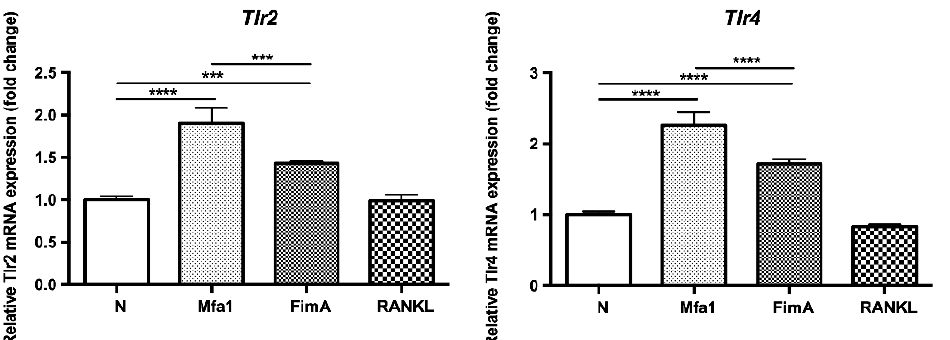
Int. J. Mol. Sci. 2022 , 23 , 15293 Figure 3. Effects of fimbriae on the expression of osteoclast differentiation marker genes in RANKL- prestimulated RAW264 cells. RAW264 cells were prestimulated with 50 ng/mL RANKL for 24 h and then cultured for 48 h in the presence of 1 µ g/mL Mfa1 and FimA fimbriae or 50 ng/mL RANKL. mRNA levels were then examined by qPCR. Values are expressed as fold changes. Differences between groups were analyzed by ANOVA and Tukey’s test. Data represent the mean ± SD ( n = 3). * p < 0.05, ** p < 0.01, *** p < 0.001, **** p < 0.0001.